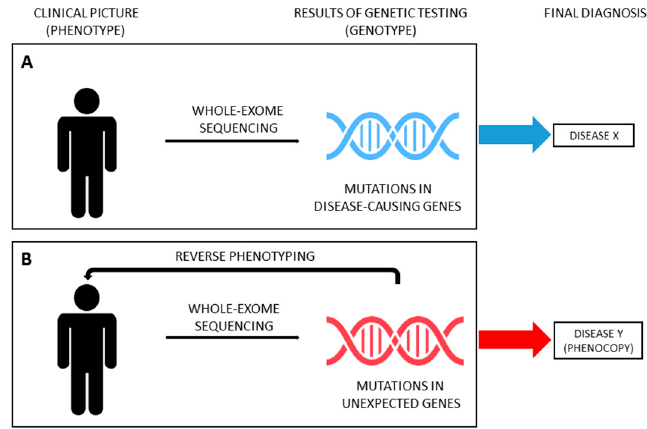
Figure 3. From phenotype to genotype, and back. ( A ) Genetic testing can be used to confirm the clinical suspect of a genetic disease, looking for mutations in disease-causing genes (from phenotype to genotype). Genetic testing can be performed either with traditional Sanger sequencing (if only one gene can cause the phenotype or if the clinical suspect is extremely high) or with NGS (if more than one gene is known to cause the disease). ( B ) Extended genotyping can result in unexpected genetic findings (i.e., mutations in genes not classically reported in association with the clinical phenotype of the patient). Reverse phenotyping represents a strategy to verify the hypothesis of a specific genetic diagnosis (from genotype to phenotype). By looking for subtle, previously overlooked clinical signs or symptoms related to the genetic diagnosis, reverse phenotyping can reclassify the diagnosis and initiate personalized clinical management.